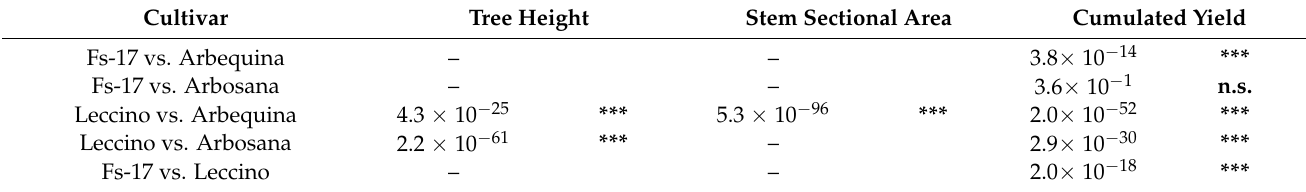
Table 5. Twin-comparison significance of von Bertalanffy functions for three agronomic parameters for cultivars Fs-17 and Leccino vs. cultivars Arbequina and Arbosana (*** p = significant at p ≤ 0.001, n.s. = not significant;